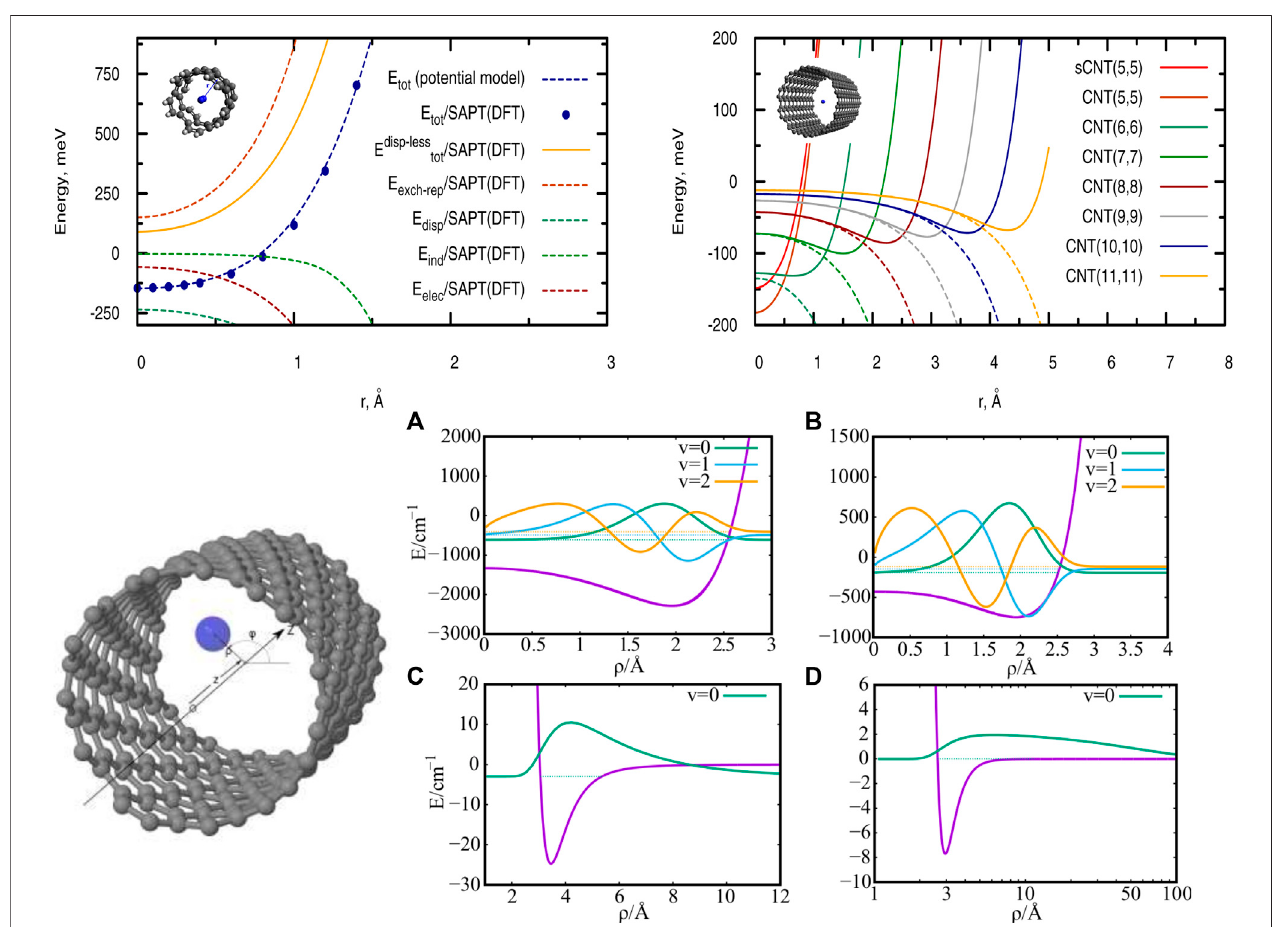
FIGURE 1 | Top panel. Left-hand side: Radialscan oftheinteractionenergies betweena singleH 2 molecule and ashort(single-walled) carbon nanotube(sCNT) ofhelicity index (5, 5). The pairwise potential model is compared with reference ab initio calculations using the SAPT(DFT) approach. Right-hand side: Radial scan of the total interaction energies (full lines) and dispersion contributions (dashed lines) between a single H 2 molecule and carbon nanotubes with helicity indexes of increasing value. Source: (de Lara- Castellsetal.,2017)Bottompanel.Left-handside:Cylindricalcoordinatesdescribingasingleparticleinatube.Right-handside:interactionpotentialsPN-CNT (A,B) andPN- PN (C,D) togetherwiththecorrespondinglow-lyingboundstatesofasinglecon fi nedPN. (A,C) :PN (cid:2) H 2 , (B,D) :PN (cid:2) 4 He.Source:(deLara-CastellsandMitrushchenkov,2021).